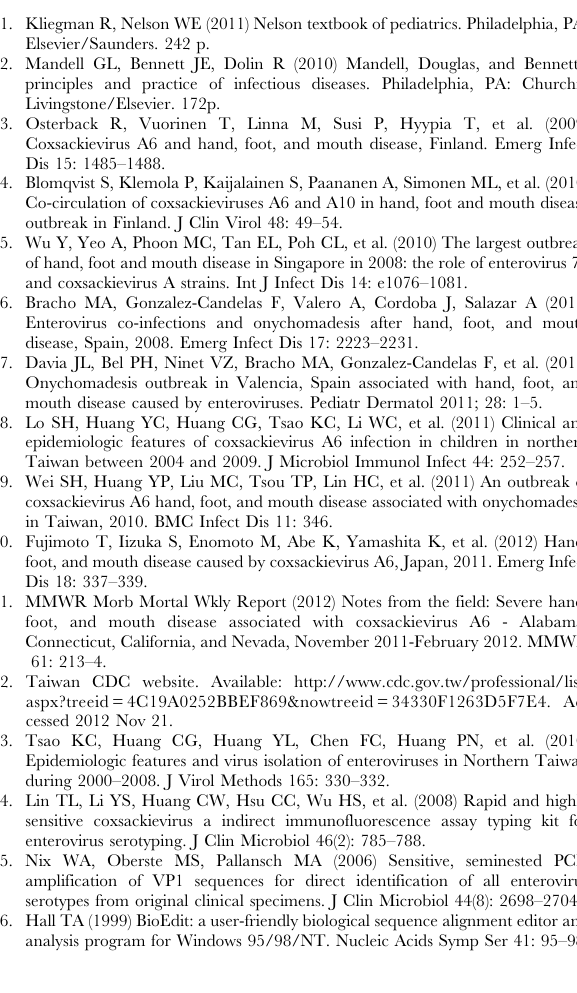
Table S3 Comparison of amino acid identities of pro- totype coxsackievirus A6 strain (Gdula) with circulating strains in